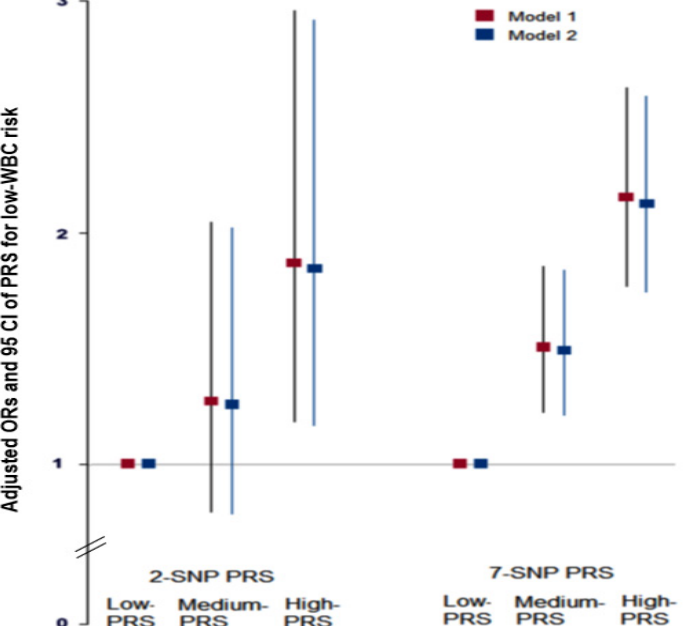
Figure 2. Adjusted odds ratios and 95% confidence intervals of the PRS of 2- and 7-SNP models generated from assessing gene-gene interactions associated with a low white blood cell (WBC) count. PRS of the 2- and 7-SNPs were calculated by summing the number of risk alleles of SNPs. PRS calculated using the 2- and 7-SNPs models were divided into three categories (0–1, 2, and ≥ 3) or (0–5, 6–7, and ≥ 8), respectively. Adjusted ORs were obtained by logistic regression after adjusting for various covariates. Two models were composed of different covariates: Model 1 included age, gender, residence area, survey year, income, and education level as covariates, and model 2 contained the variables in model 1 plus energy intake, smoking status, physical activity, alcohol intake, autoimmune diseases, and serum high-sensitive C-reactive protein concentrations as variates. The low-PRS group was used as a reference for logistic regression. Based on the covariates, red and blue boxes indicated adjusted ORs for models 1 and 2, respectively, and lines indicated 95% CIs. 3.4. Associations between PRS Derived from the 7-SNP Model and MetS and Its Components There was no significant association between PRS and MetS after adjusting for co- variates (Supplementary Table S3). BMI and body fat mass also did not have an associa- tion with PRS (Supplementary Table S3). MetS components including waist circumfer- ences, plasma glucose, HDL, triglyceride concentrations were not associated with PRS af- ter adjusting for covariates (Supplementary Table S3). Serum hs-CRP concentrations did not have any relation with PRS (Supplementary Table S3). 3.5. Interaction between PRS and Nutrient Intakes and a Low WBC Count Risk No interactions were observed between PRS and age, gender, BMI, or metabolic syn- drome that affected low-WBC count risk ( p > 0.05). There was no interaction between life- styles (except fat intake), PRS, and low-WBC risk ( p = 0.008; Table 5). In participants with a high fat intake, those with a low-PRS had much higher WBC counts than those with a medium or high-PRS (Figure 3). This trend was similar in the low-fat intake. The associa- tion between PRS and WBC counts was greater for participants with high-fat intakes than low-fat intakes (Table S5).